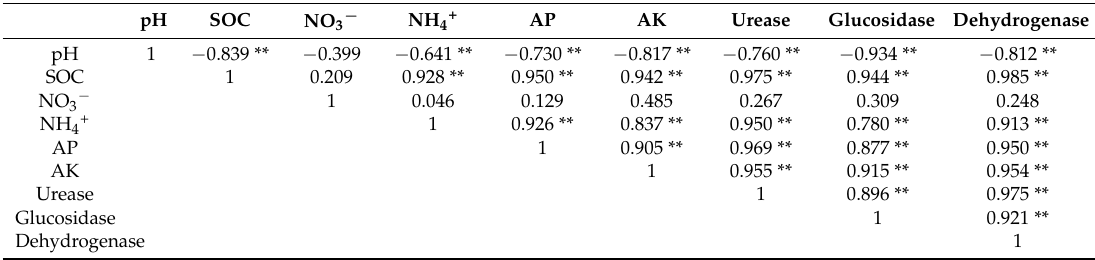
Table 3. Bivariate correlation test between physicochemical properties and soil enzymes activity after wheat plants